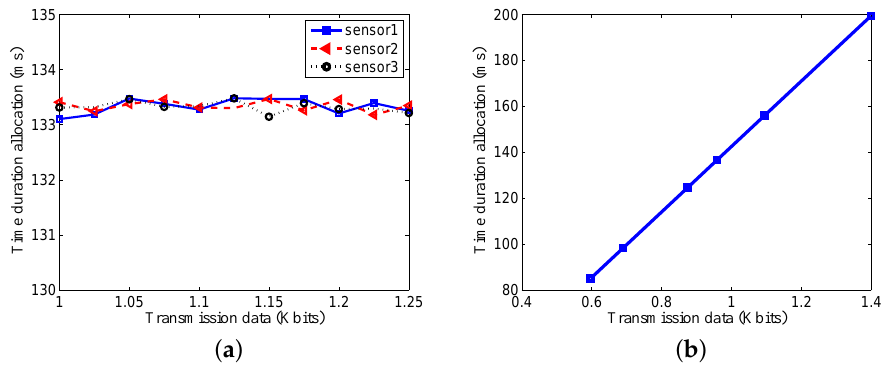
Figure 5. ( a ) Effects of transmission data size ω on time duration allocation under different sensors; ( b ) Effects of transmission data size ω on time duration allocation under a given data